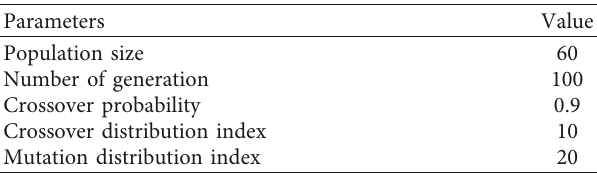
Figure 9: Pareto fronts of three surrogate models with different parameters (population size; generation numbers). Table 2: Parameters adopted for